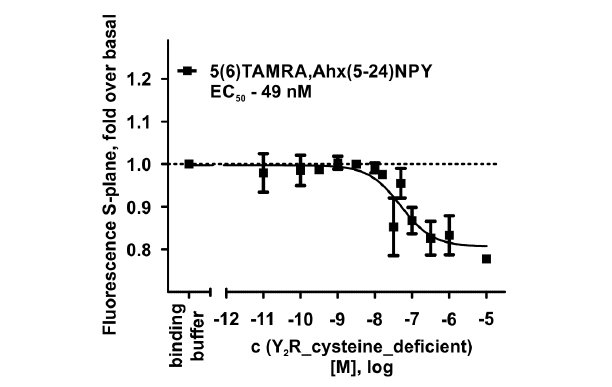
FIGURE 3 | Fluorescence polarization assay of 5 nM 5(6)-TAMRA labeled, short NPY [5(6)-TAMRA-Ahx(5-24)NPY] with increasing amounts of cell-free expressed Y 2 R_cysteine_deficient in Brij-58 micelles. Data show a reduction in fluorescence S-plane upon 5(6)-TAMRA-Ahx(5-24)NPY binding after 60 min incubation at room temperature. The determined EC 50 value was 49 nM. EC 50 and pEC 50 ± s.e.m. were determined using GraphPad Prism 5.0. All curves were baseline corrected to the S-Plane fluorescence without receptor (binding buffer) n ≥ 2.